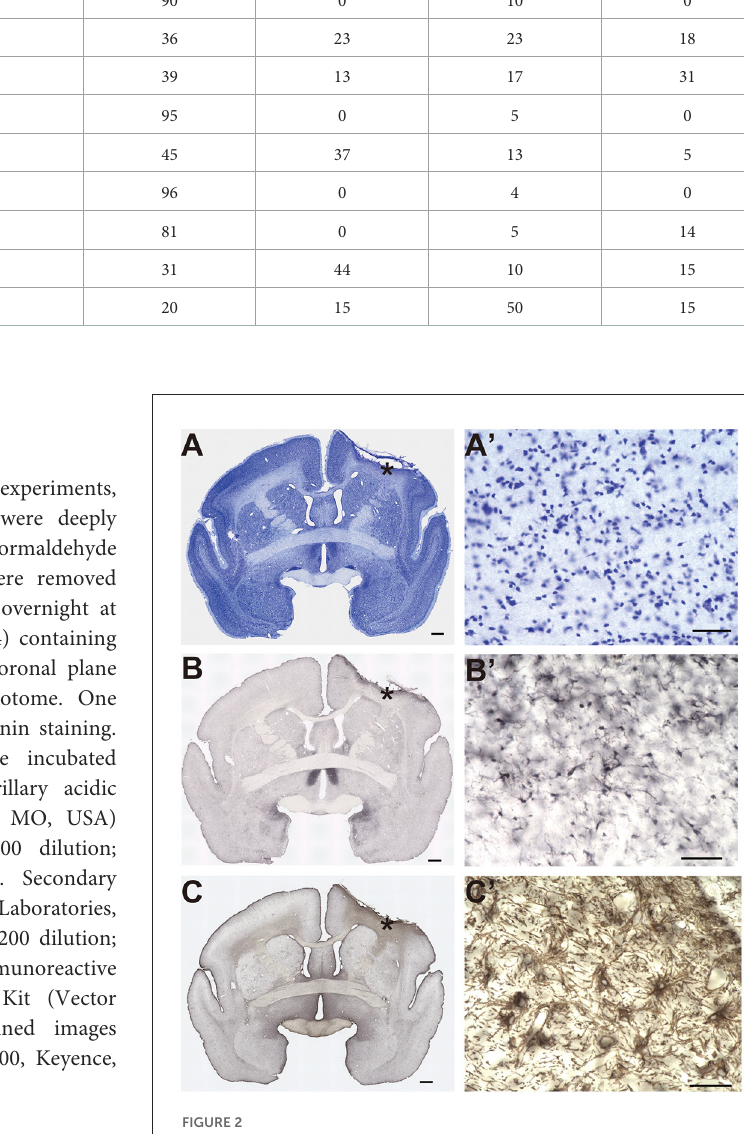
FIGURE2 Histological identification of the lesion area. (A–C) Representative image of Nissl staining (A) , Iba-1 immunostaining (B) , and glial fibrillary acidic protein immunostaining (C) . Asterisks indicate the locations of the higher magnification view shown in (A’–C’). Scale bar, 1mm for (A–C) , and 50 µ m for (A’–C’)